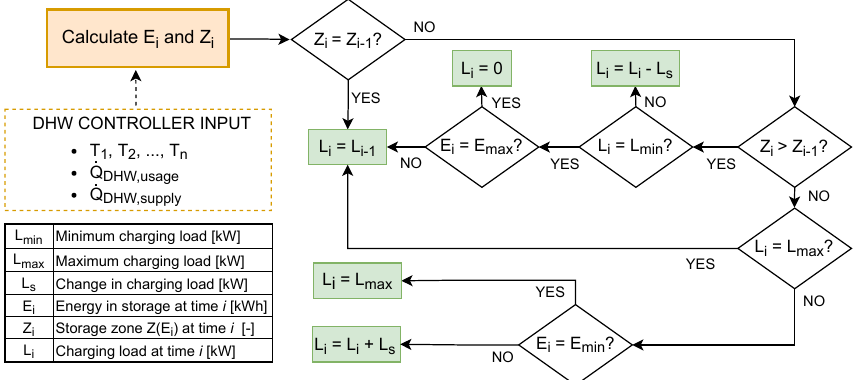
Figure 3. Simplified decision tree control logic to determine DHW charging load with the leveled charging